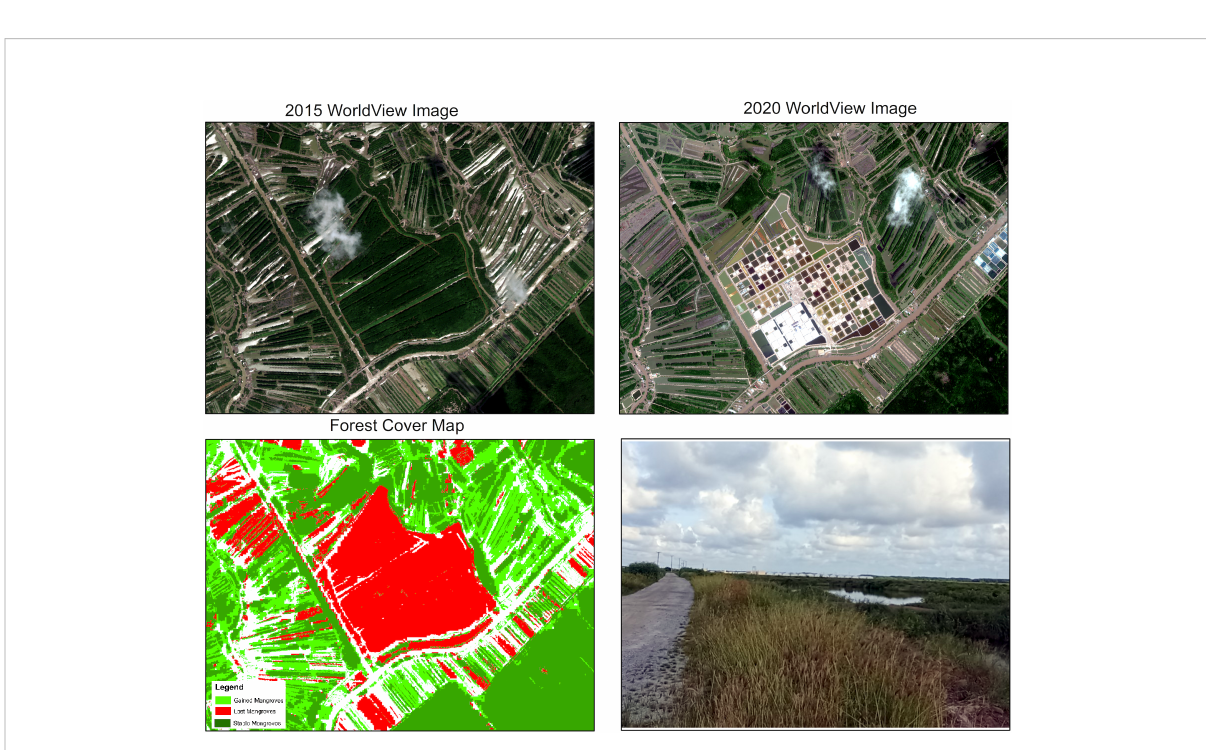
FIGURE 6 Mangrove conversion to other land uses (road and intensive